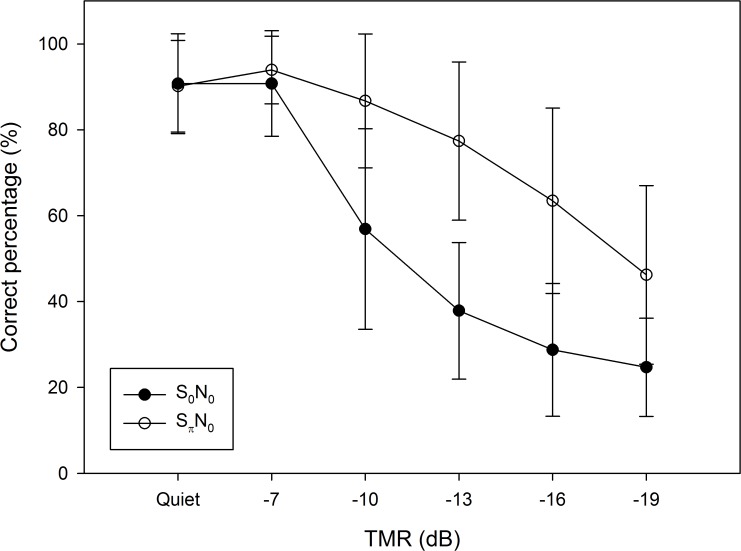
Mandarin tone recognition scores in quiet and TMR values in the S0N0 and SπN0 conditions.Data are mean and SD values.